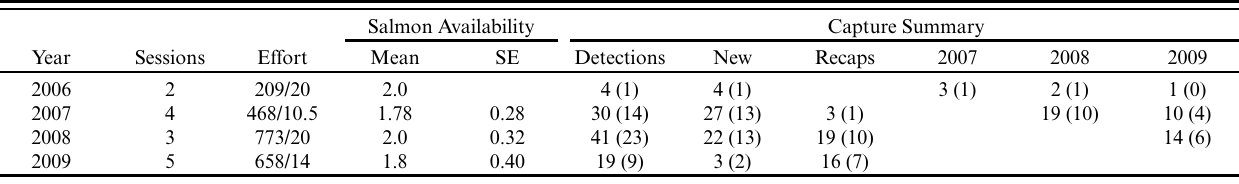
Table 2 . Summary of sampling effort for Koeye grizzly bear ( Ursus arctos horribilis ) DNA mark-recapture analysis 2006-2009. Salmon availability numbers are observational indices calculated in the field during each session (see text). Effort is presented as snare days/ average snares set. The number of unique bears detected each year is given along with whether they were new bears or recaptures. The number of recaptures in the subsequent years is shown for bears detected in each year. The number of female bears (from the total bears listed) is given in parenthesis. For example, in 2006, 4 bears were detected of which 1 was a female. Recaptures for each of the three years subsequent to the first sampling period (2006) are divided by year in the three columns adjacent to the total